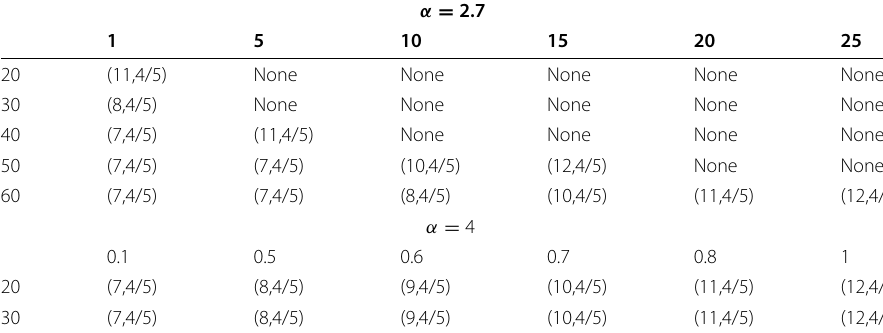
Table 3 Optimal SF and CR settings in different cases